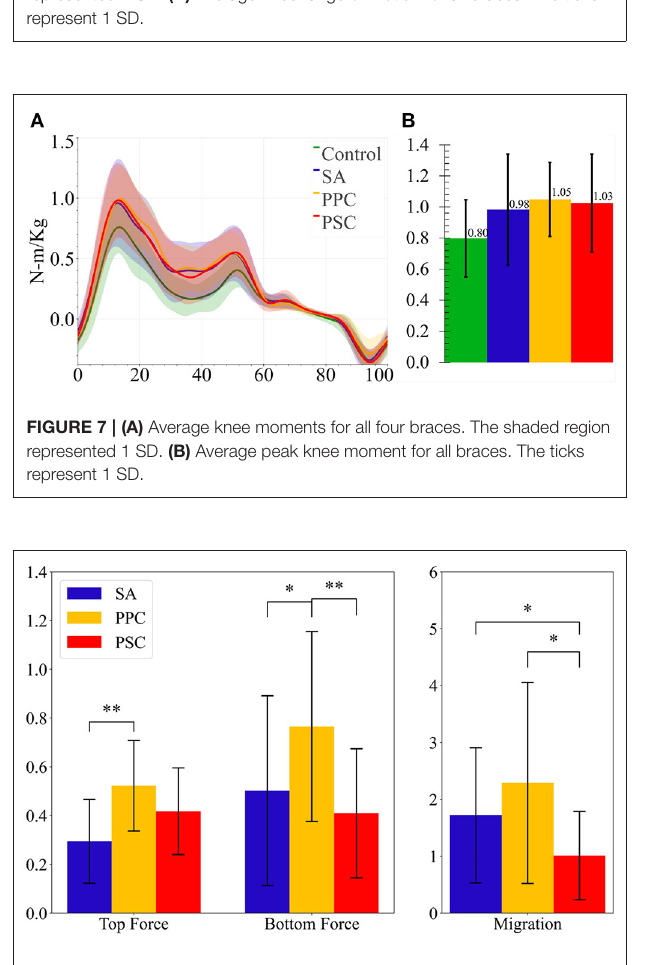
FIGURE 8 | Average interaction force at the top and bottom force sensors and average device migration results. The ticks represent 1 SD. The symbol * signifies p < 0.05 and ** implies p <